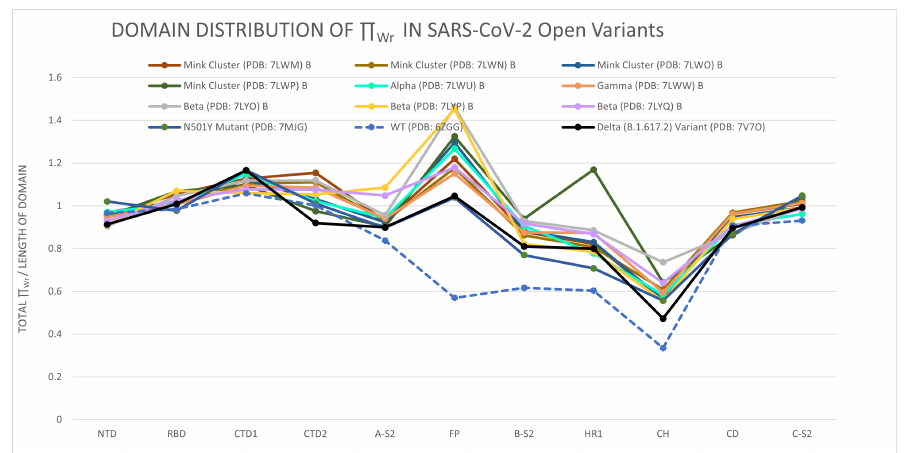
Figure 5. The distribution of the total local topological free energy in SARS-CoV-2 Spike protein domains for the WT and variants in open